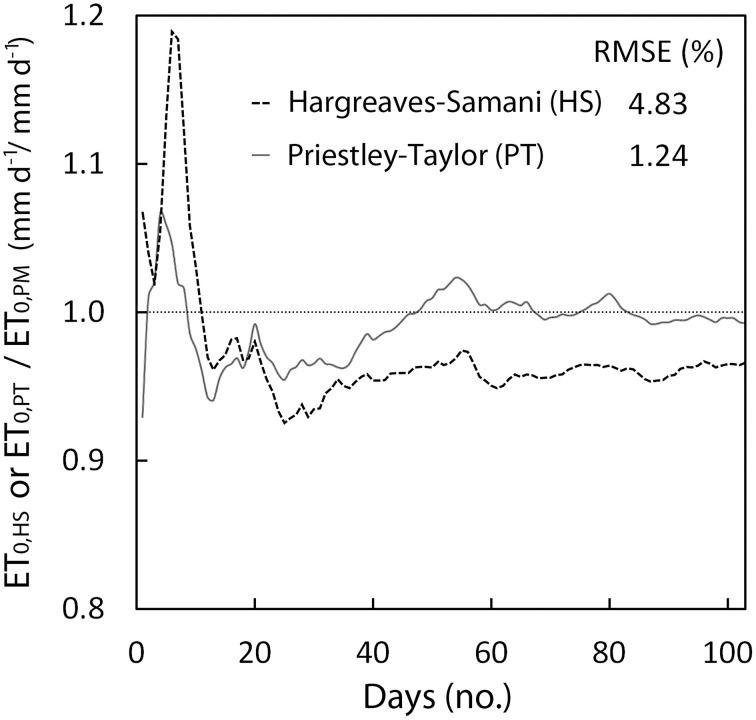
Deviations in daily ET0 estimates of the Hargreaves and Priestley-Taylor model, after being calibrated for the area, compared with the Penman–Monteith model. The test relates to a typical period for a processing tomato crop in the Foggia area (Southern Italy) and is given as an example of the accuracy of the Hargreaves and Priestley-Taylor model after site calibration.